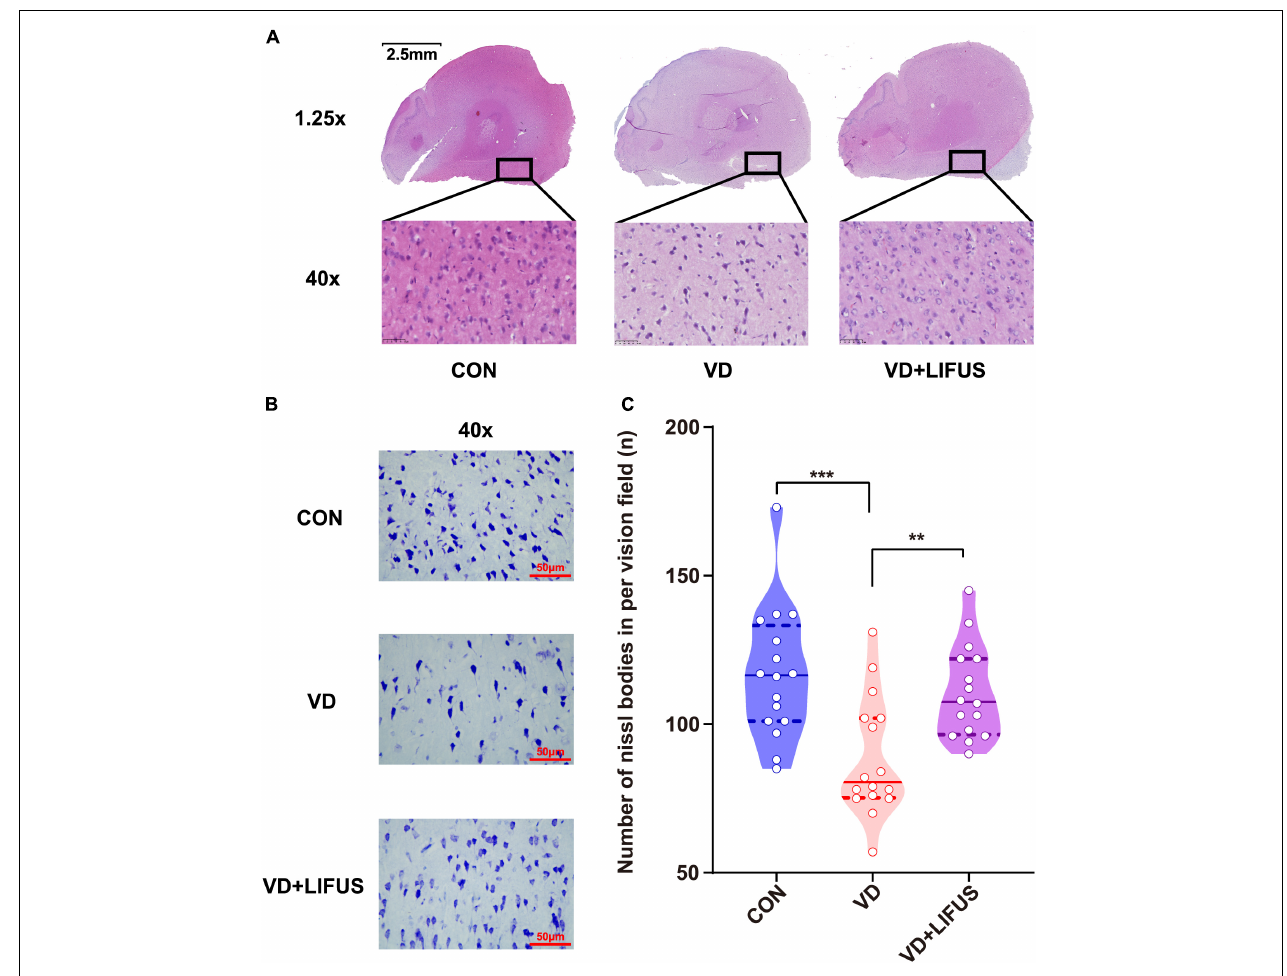
FIGURE 4 | Effect of LIFUS on the morphological changes of the neurons and ability of protein synthesis in the VD rats. (A) Typical diagrams of HE in three groups. (B) Typical diagrams of Nissl staining in three groups. (C) The statistical results of the number of Nissl bodies. Data are expressed as mean ± SEM. ** p < 0.01, *** p < 0.001 (CON, VD, VD + LIFUS, n =